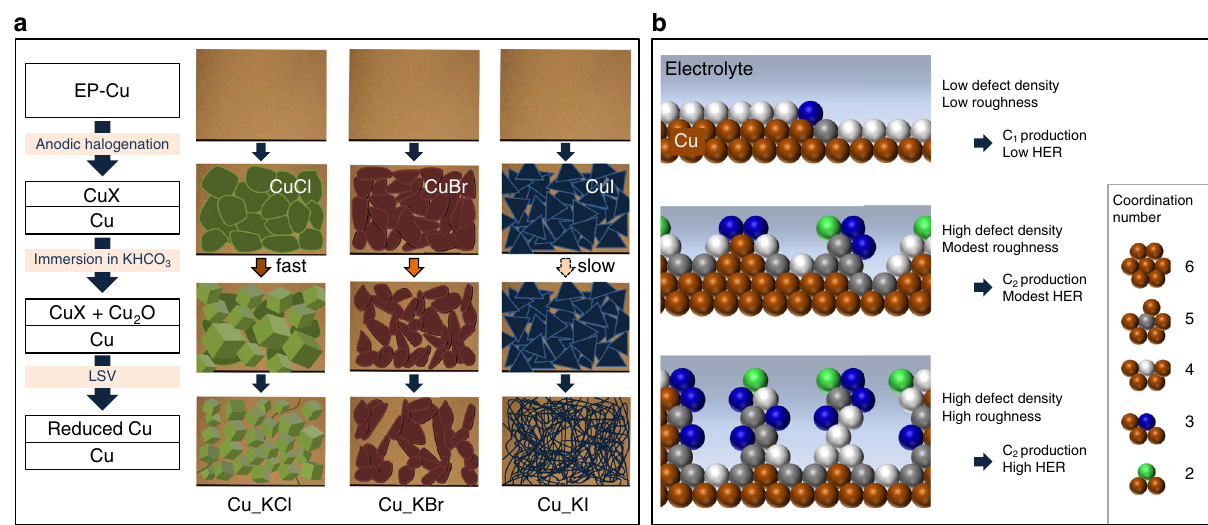
Fig. 1 Schematics showing morphology of Cu catalysts. a The method used to prepare Cu catalysts for electrochemical CO 2 RR: anodic halogenation in KX solutions where X = halogen, oxide formation in basic KHCO 3 , and electroreduction in neutral KHCO 3 by LSV. EP-Cu corresponds to electropolished Cu foils, LSV corresponds to linear sweep voltammetry. b Two-dimensional visualization of under-coordinated Cu atoms and surface roughness with the corresponding outcomes when used for the electrochemical CO 2 RR. This schematic is simpli fi ed but face-centered cubic Cu has a coordination number of 12.